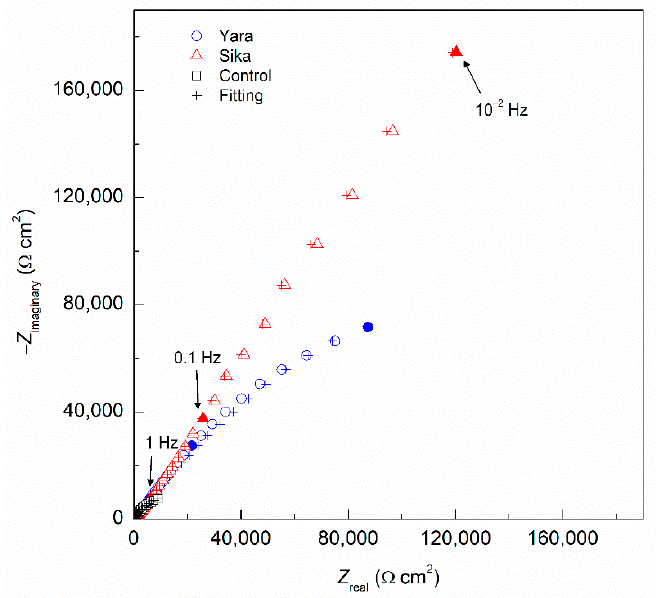
Figure 8. Nyquist plots for steel rebar exposed to commercial corrosion inhibitors blends (Sika and Yara) in 0.6 M NaCl SCPS. Table 4. The EIS parameters obtained for rebar exposed to commercial corrosion inhibitor blends (Sika and Yara) in simulated concrete pore solution with 0.6 M